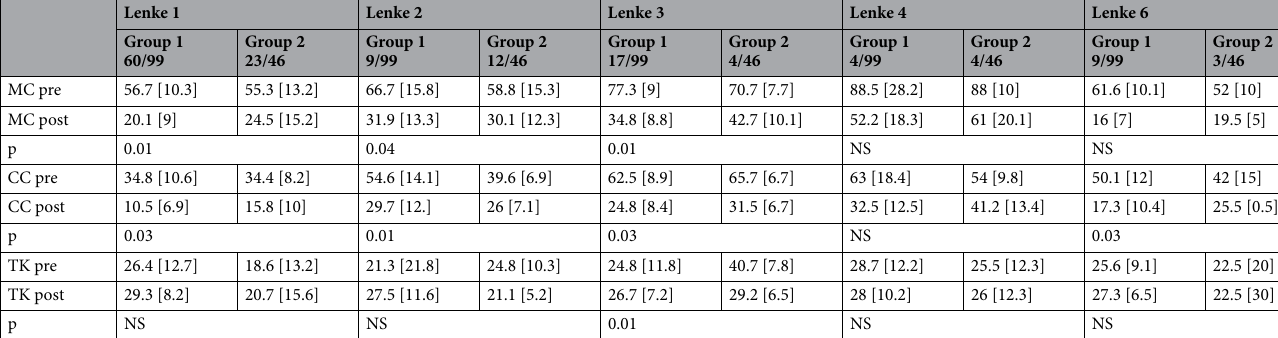
NS Table 9. Radiographic data considering Lenke distribution mean [standard deviation]; analysis performed using IBM SPSS Statistics 21. MC, main curve; CC, compensatory curve, TK, thoracic kyphosis; NS, not significant.